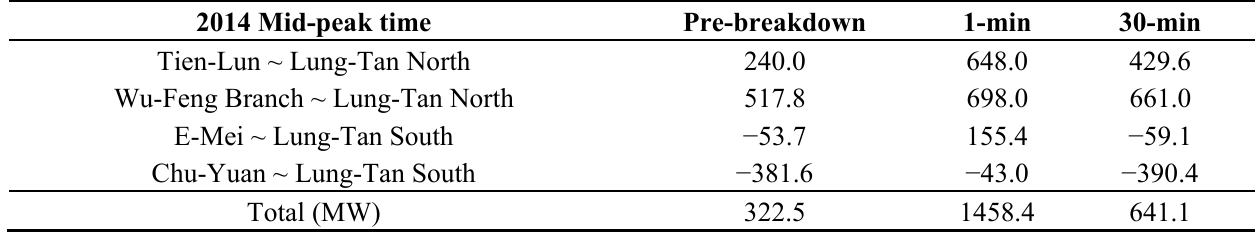
Table 6. Comparison between the central to northern power flow capacities post failure for mid-peak time in 2014.